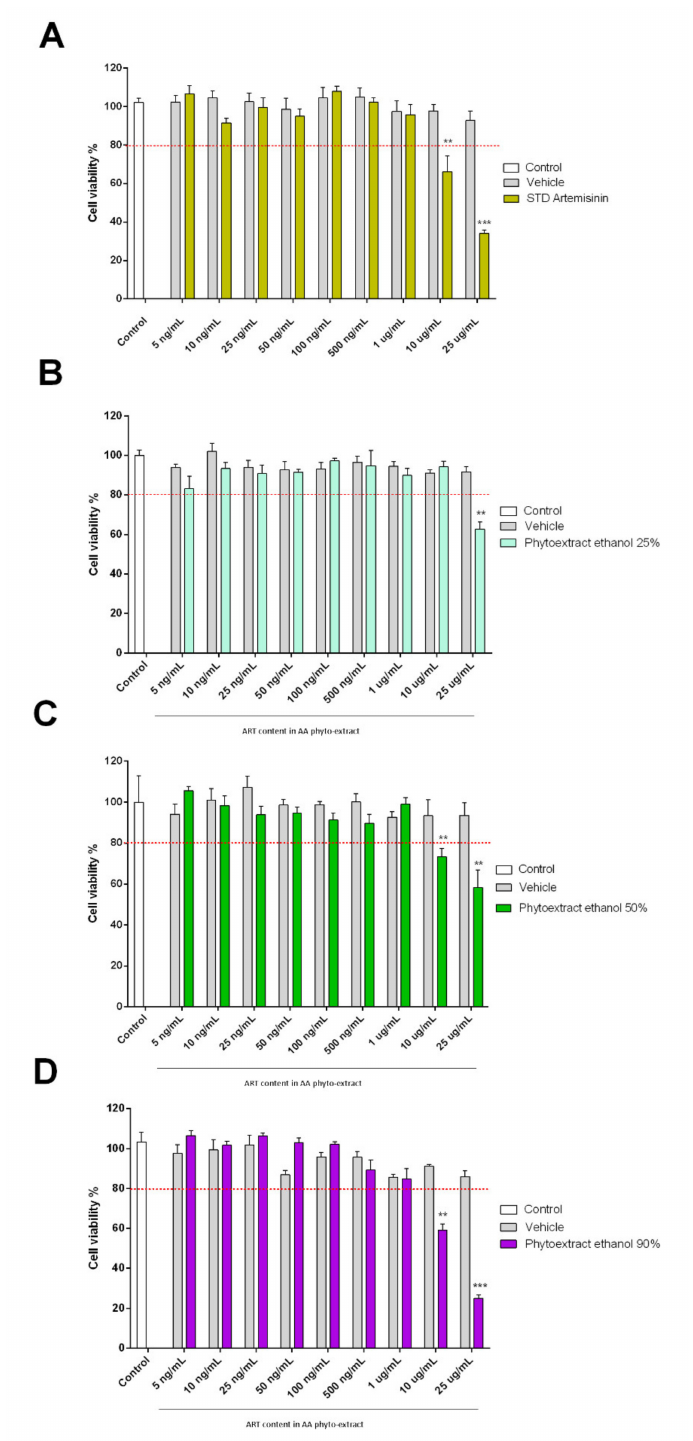
Figure 6. Effects of ethanolic extracts of Artemisia annua L. on SH-SY5Y cell viability. The bars indicate the percent cell viability of cells treated with ( A ) artemisinin standard; ( B ) phyto-extracts of AA in 25% ethanol; ( C ) phyto-extracts of AA in 50% ethanol; and ( D ) phyto-extracts of AA in 90% ethanol with the indicated concentrations (ranging from 25 µ g/mL to 5 ng/mL) for 48 h and subjected to an MTT assay. Phyto-extract treatments were performed so that the ART content within the phyto-extracts was at the same concentration of STD Artemisinin. This estimation was calculated based on the phyto-extract ART quantification by HPLC. Data are representative of three replicates and shown as mean ± standard deviation; *** p < 0.001 vs. control group; ** p < 0.005 vs. control